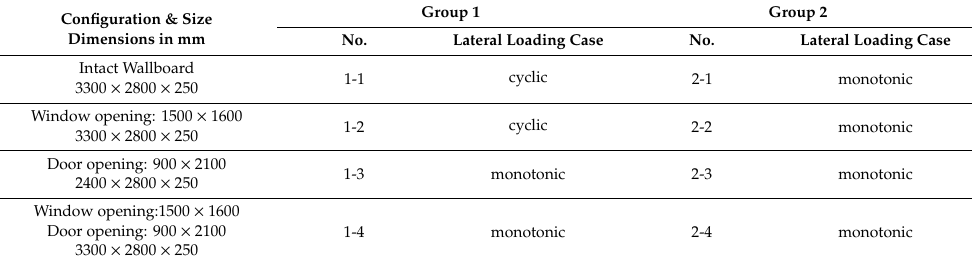
Figure 3. Construction process. Table 1. The configurations and sizes of the experimental HMES wallboards.